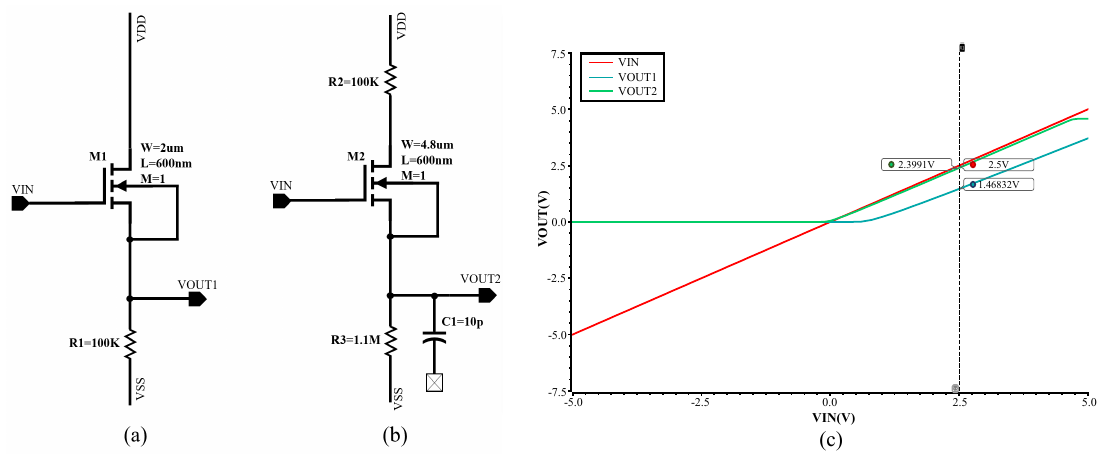
Figure 8. Circuits and simulation for the rectified linear unit (ReLU) activation function. ( a ) A source follower circuit. ( b ) Our improved source follower circuit. ( c ) Simulation results for both circuits.